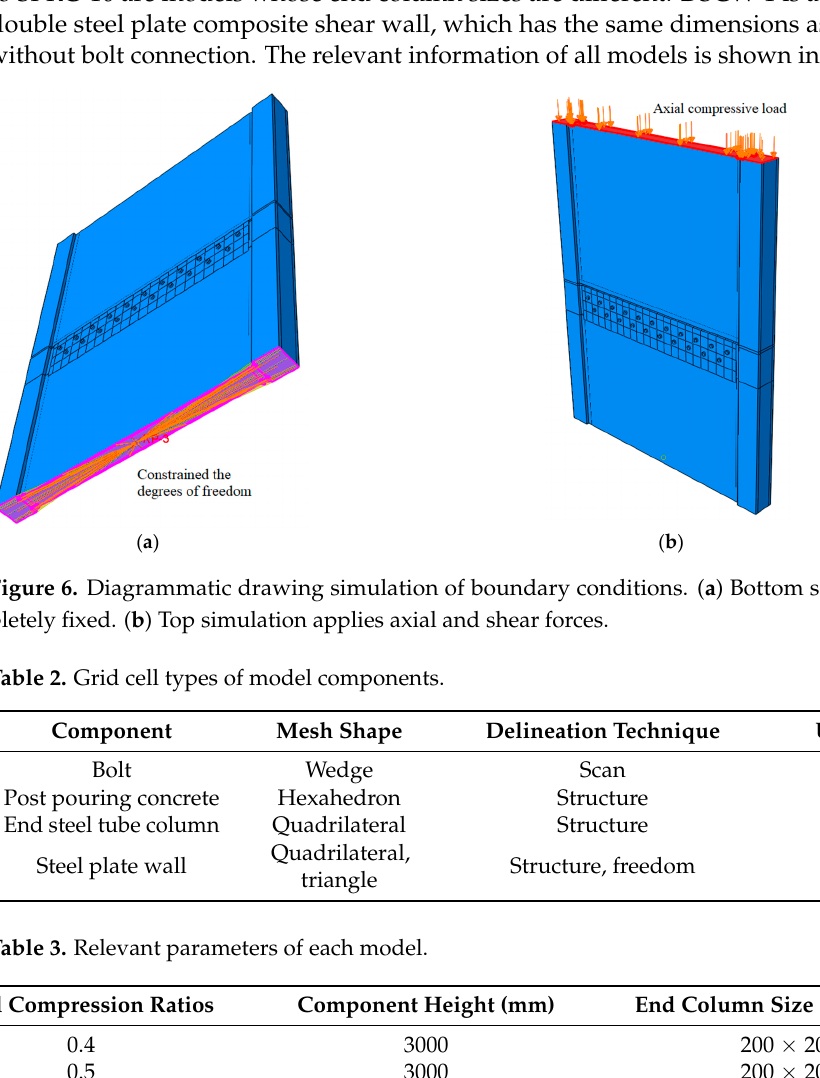
Figure 5. Diagrammatic drawing of simulation assembly 1.